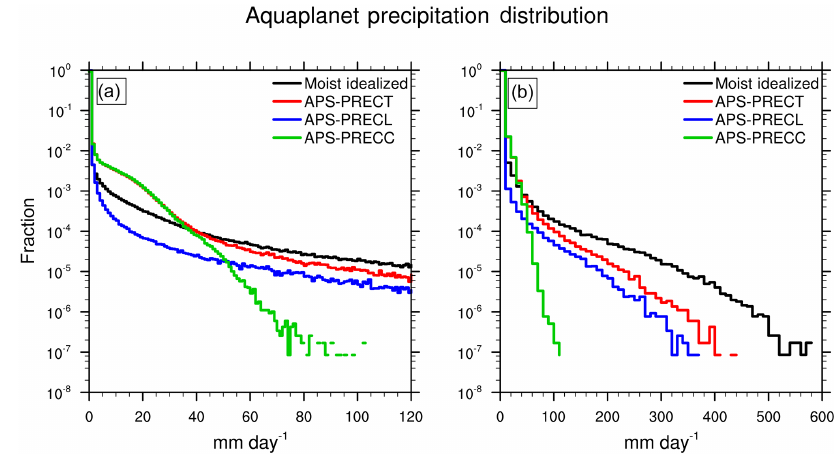
Figure 5. Precipitation frequency distribution of the SE precipitation rates averaged between ± 10 ◦ for MITC (black), aquaplanet total precipitation (PRECT, red), large-scale precipitation (PRECL, blue), and convective precipitation (PRECC, green) ranging from (a) 0 to